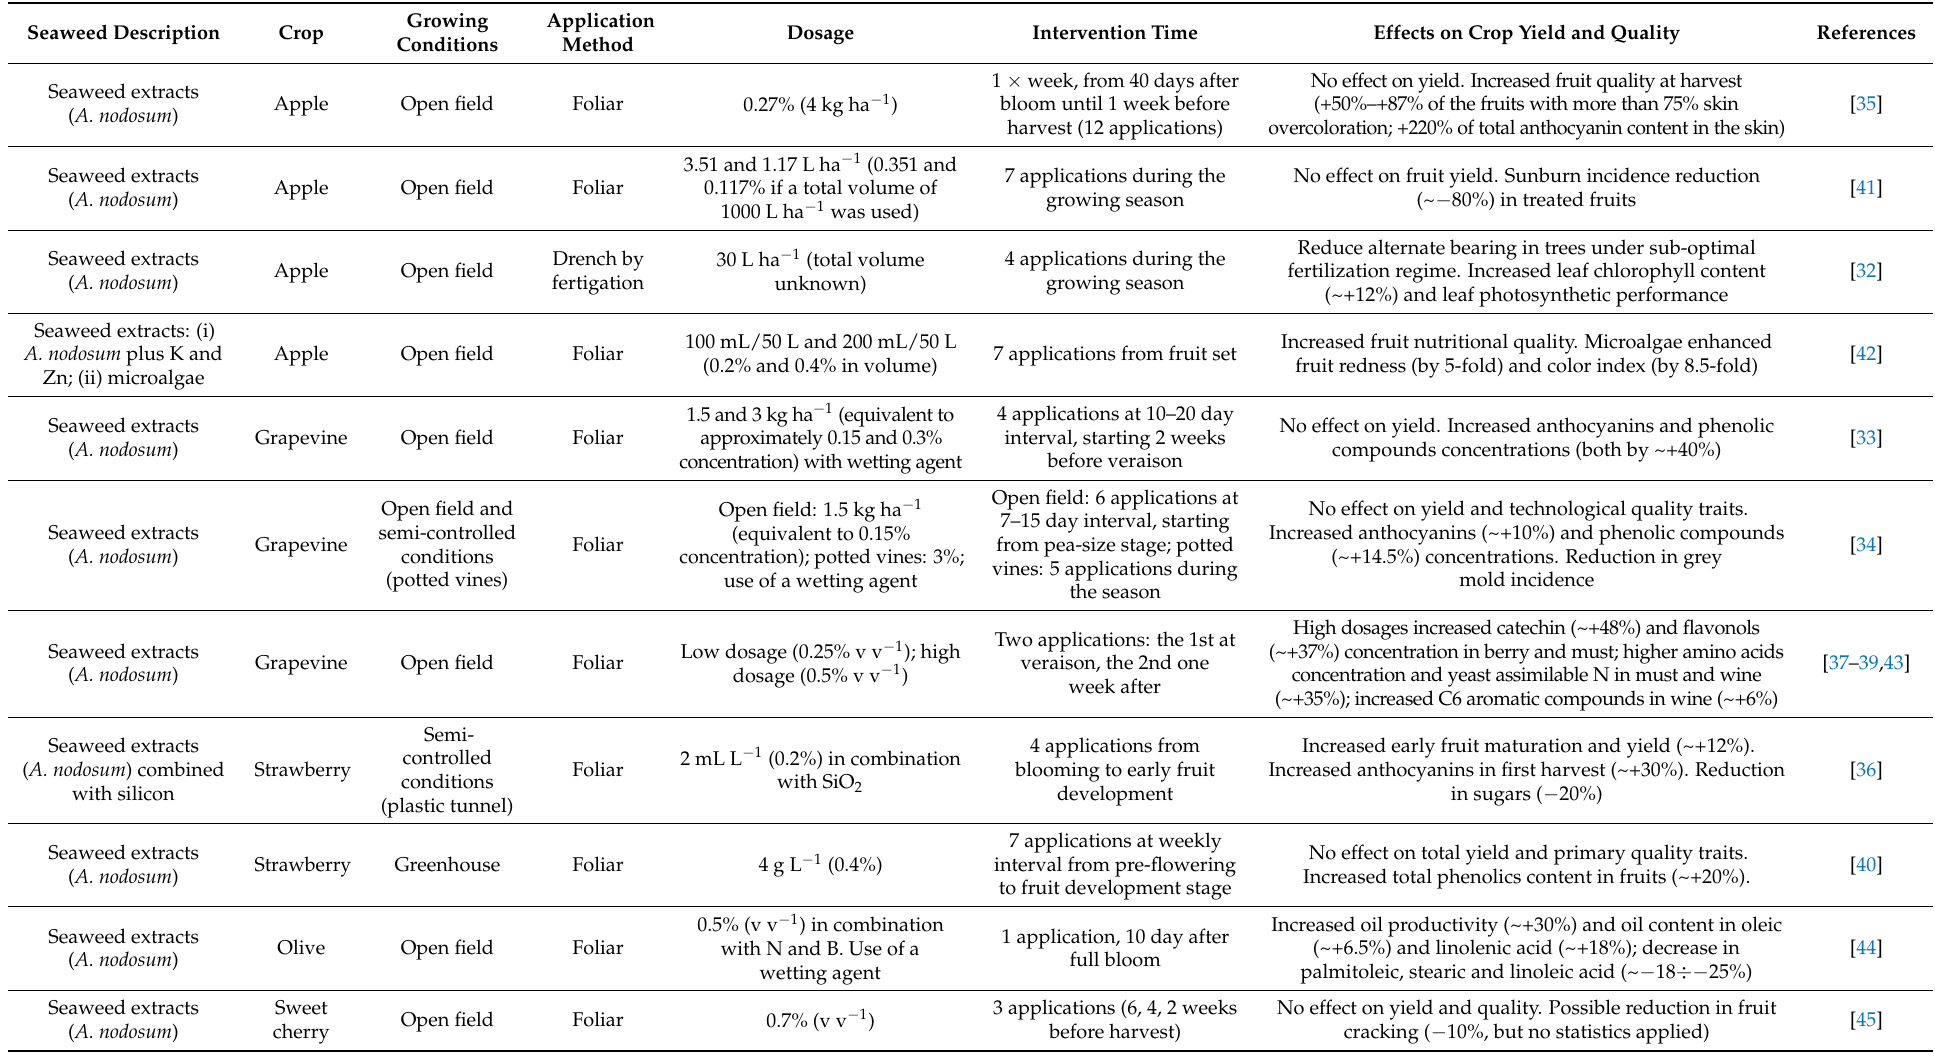
Table 3. Seaweed application methods to increase yield and product